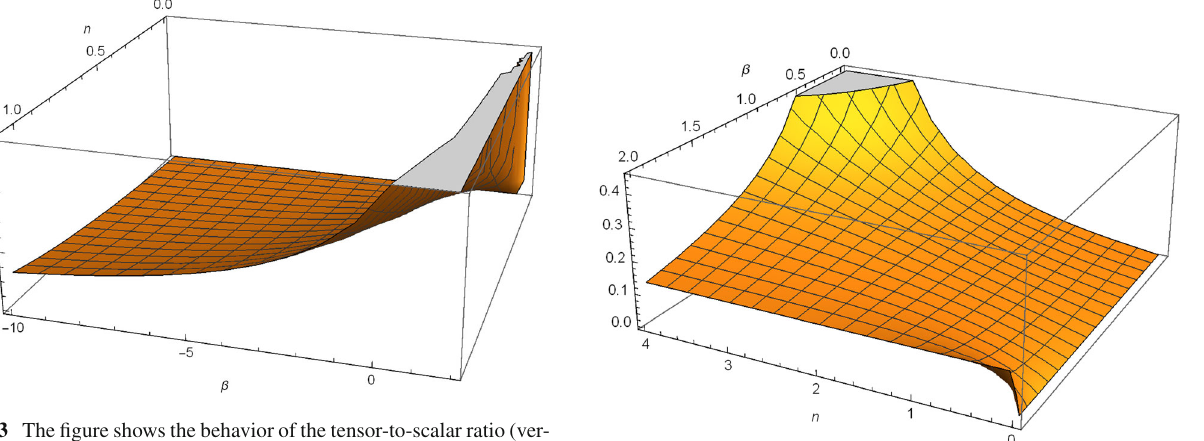
Fig. 3 The figure shows the behavior of the tensor-to-scalar ratio (ver- ticalaxis).Weusetheranges β = [− 10 , 2 ] , n = [ 0 , 1 . 1 ] withthevalues γ = 0 . 018, N = 60